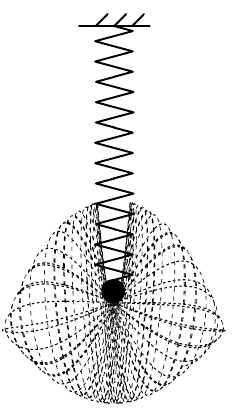
Figure 4. Locus of the SP.